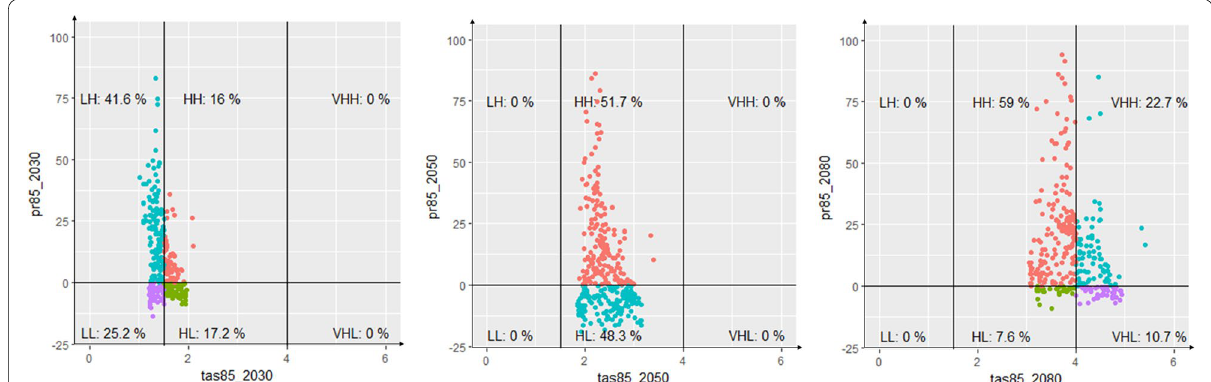
Fig. 3 Combined variability of temperature in DegC (X-axis) and rainfall in mm/day (Y-axis) under RCP 8.5 (left to right: 2030, 2050, 2080). LH: Low temperature High precipitation, HH: High temperature High precipitation, VHH: Very High temperature High precipitation, LL: Low temperature Low precipitation, HL: High temperature Low precipitation, VHL: Very High temperature Low